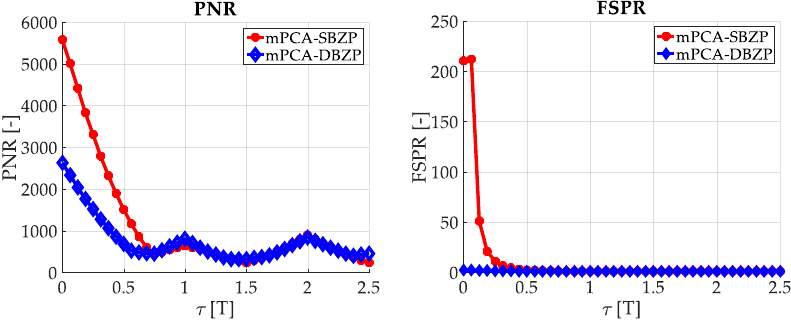
Figure 10. Result of PCS, mPCA pre-correlation processing of SC .